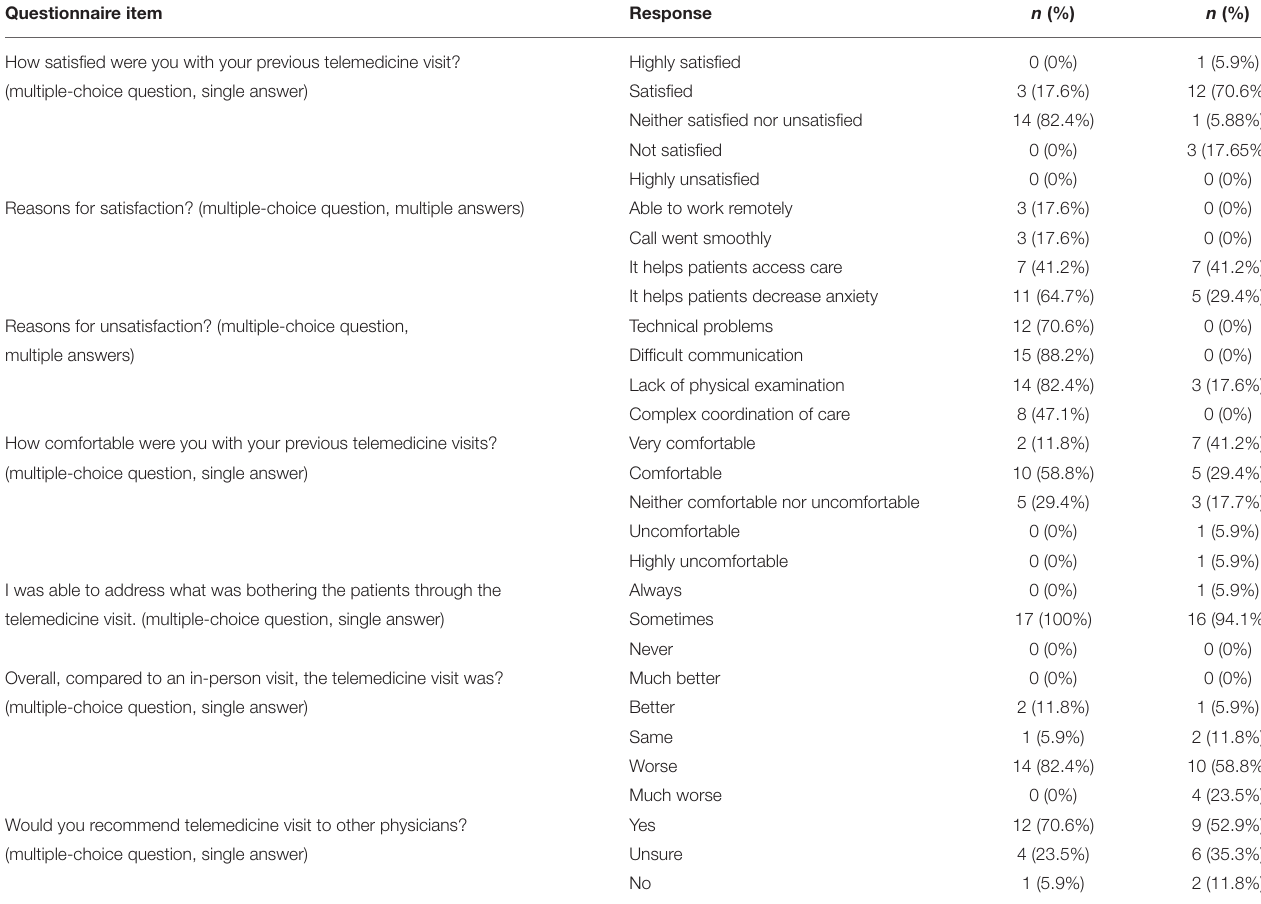
TABLE 3 | Telemedicine